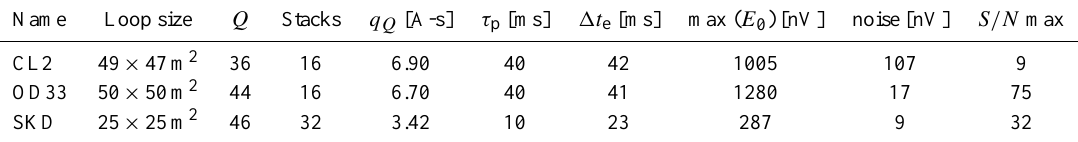
Table 2. Acquisition parameters: loop sizes, number of pulse moments Q and stacks, maximum pulse q Q , pulse length τ p and effective dead time 1t e (see Dlugosch et al., 2011), maximum of the initial amplitudes max ( E 0 ), noise after stacking, and S/N corresponding to max( E 0